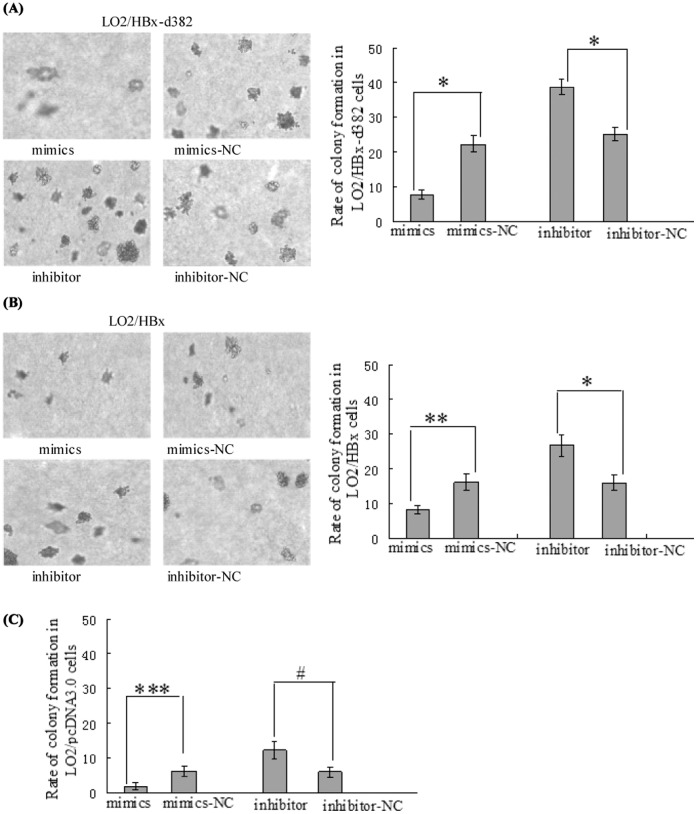
miR-338-3p influence the colony formation of transfected LO2 cells.(A–B) Gain of miR-338-3p decreases the rate of colony formation of LO2/HBx-d382 and LO2/HBx cells, whereas loss of miR-338-3p enhances the non-anchored growing ability in HBx-expressing cells (*P<0.001, **P<0.01). (C) The non-anchored growing ability of control LO2/pcDNA3.0 cells are also inhibited by miR-338-3p, although the significant difference is lower than that in HBx-expressing cells (***P = 0.032,#P = 0.025).